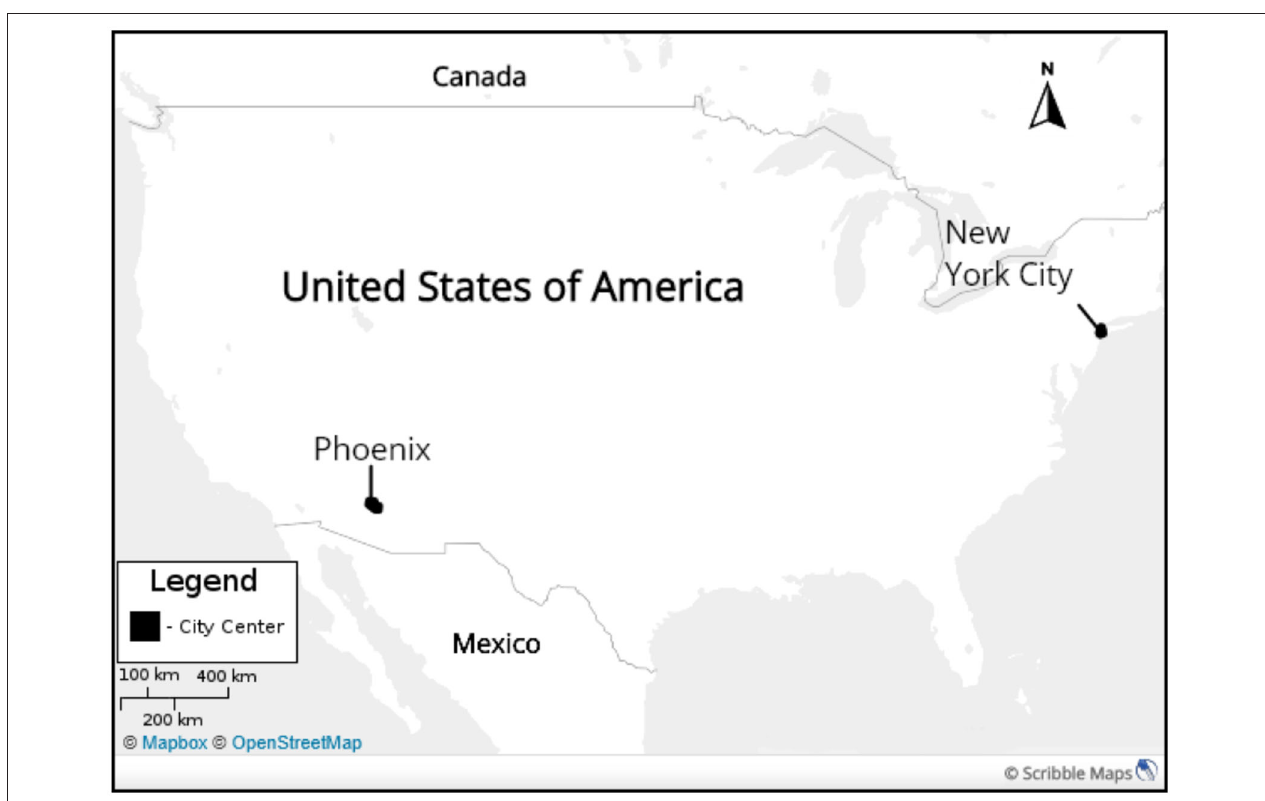
FIGURE 1 | The location of the study sites within North America. Map created using Open Street Maps and Scribble Maps: http://openstreetmaps.org/; https://www. scribblemaps.com/.